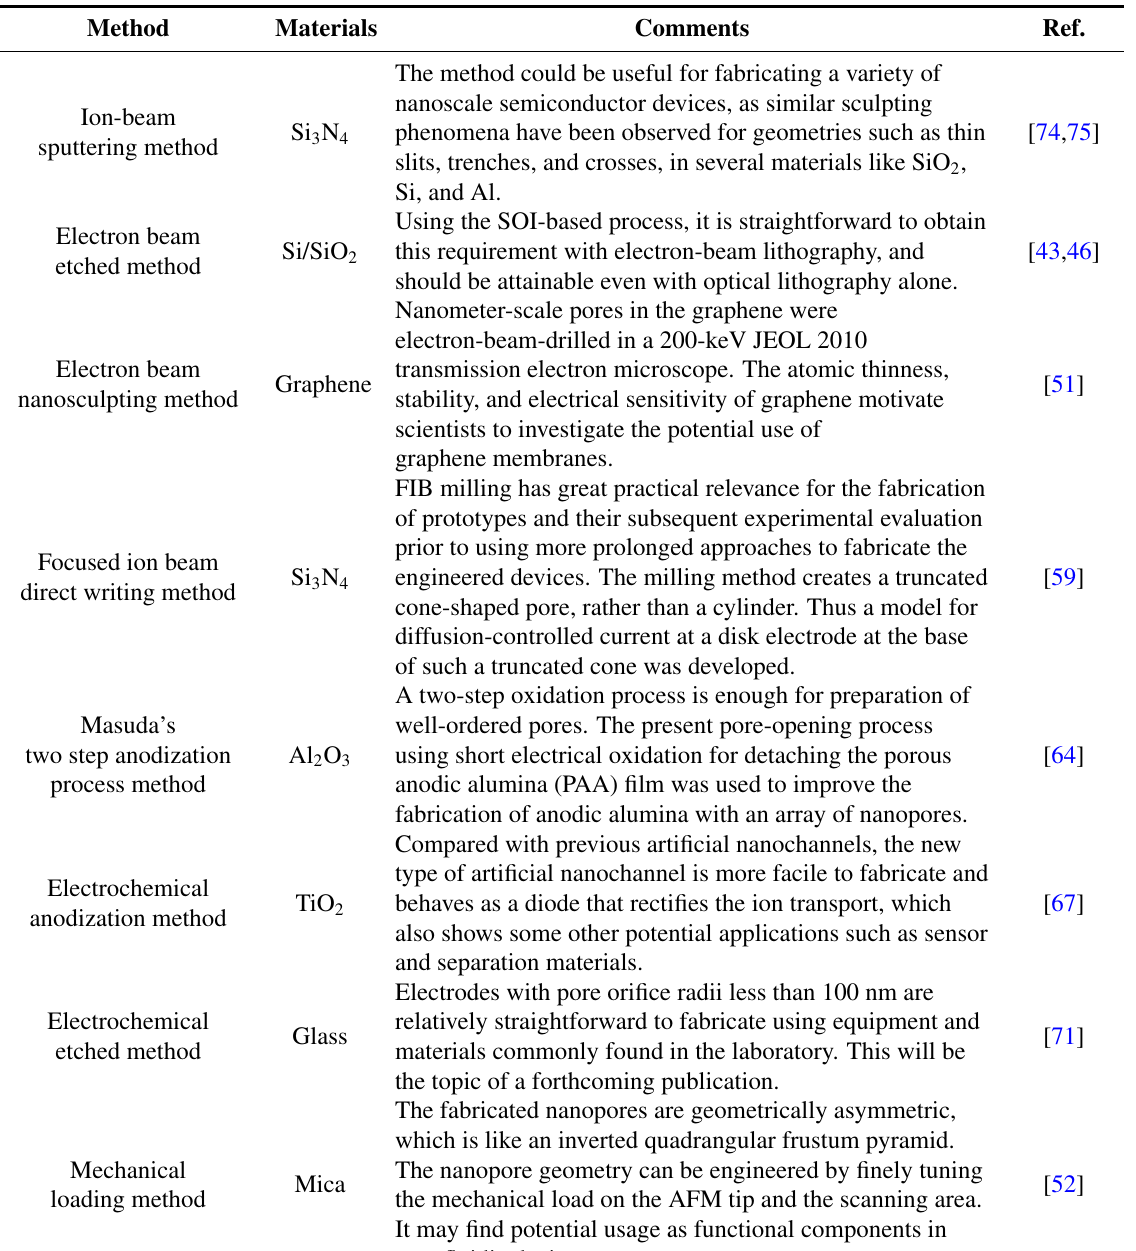
Table 3. Comments on various typical fabrication methods for nanochannels in